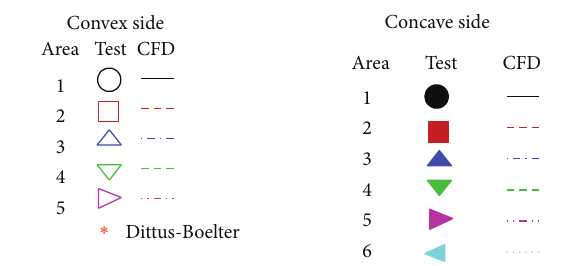
Figure 10: Comparison of the measured and CFD heat transfer results in the smooth channel on the convex and concave walls for the case of closed trailing-edge hole.